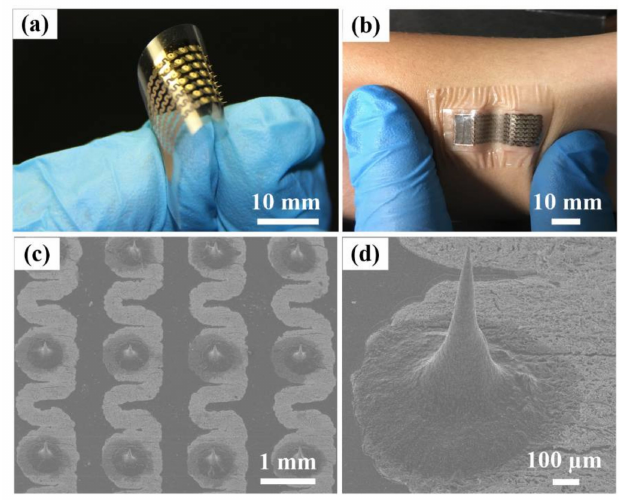
Figure 3. ( a ) Image of the flexible MAE, ( b ) image of the flexible MAE on the curved skin, ( c ) SEM (scanning electron microscope) image of the flexible MAE, and ( d ) SEM image of a microneedle.